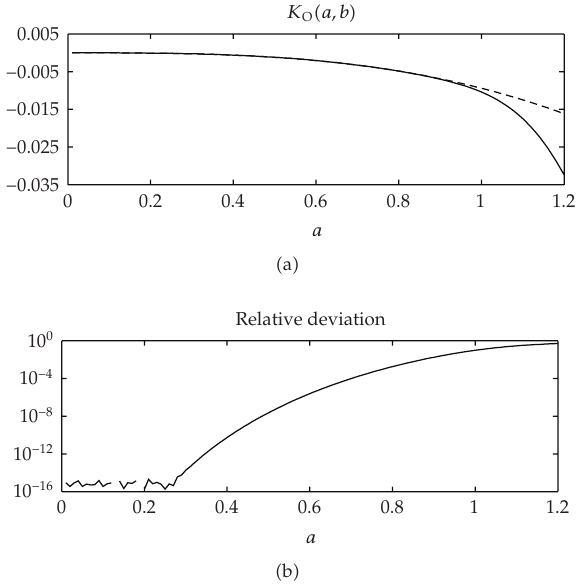
Figure 11: Comparison of the direct series evaluation (cid:2) solid (cid:3) and the analytic representation (cid:2) dashed (cid:3) for the odd-order spectra K O with n (cid:6) 1, b (cid:6) 0 . 25 as a is varied. The inset shows the relative di ff erence between the direct series evaluation and the analytic representation.